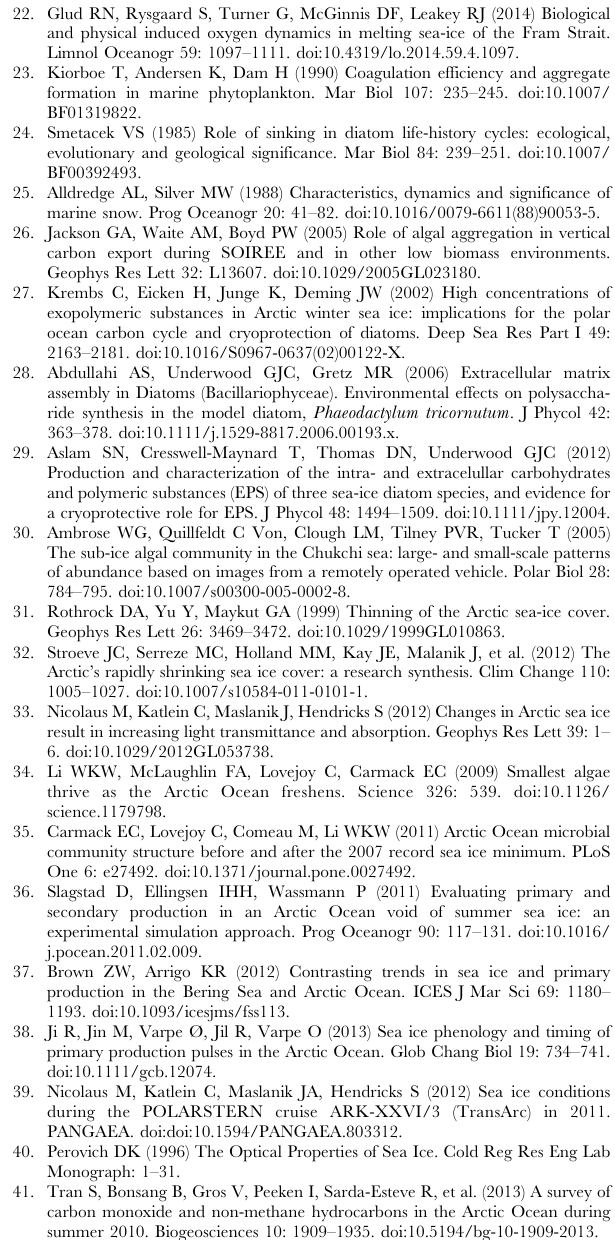
Table S1 Characteristics of pennate algal aggregates and sea ice stations investigated. Table S2 Characteristics of Melosira algal aggregates and sea ice stations